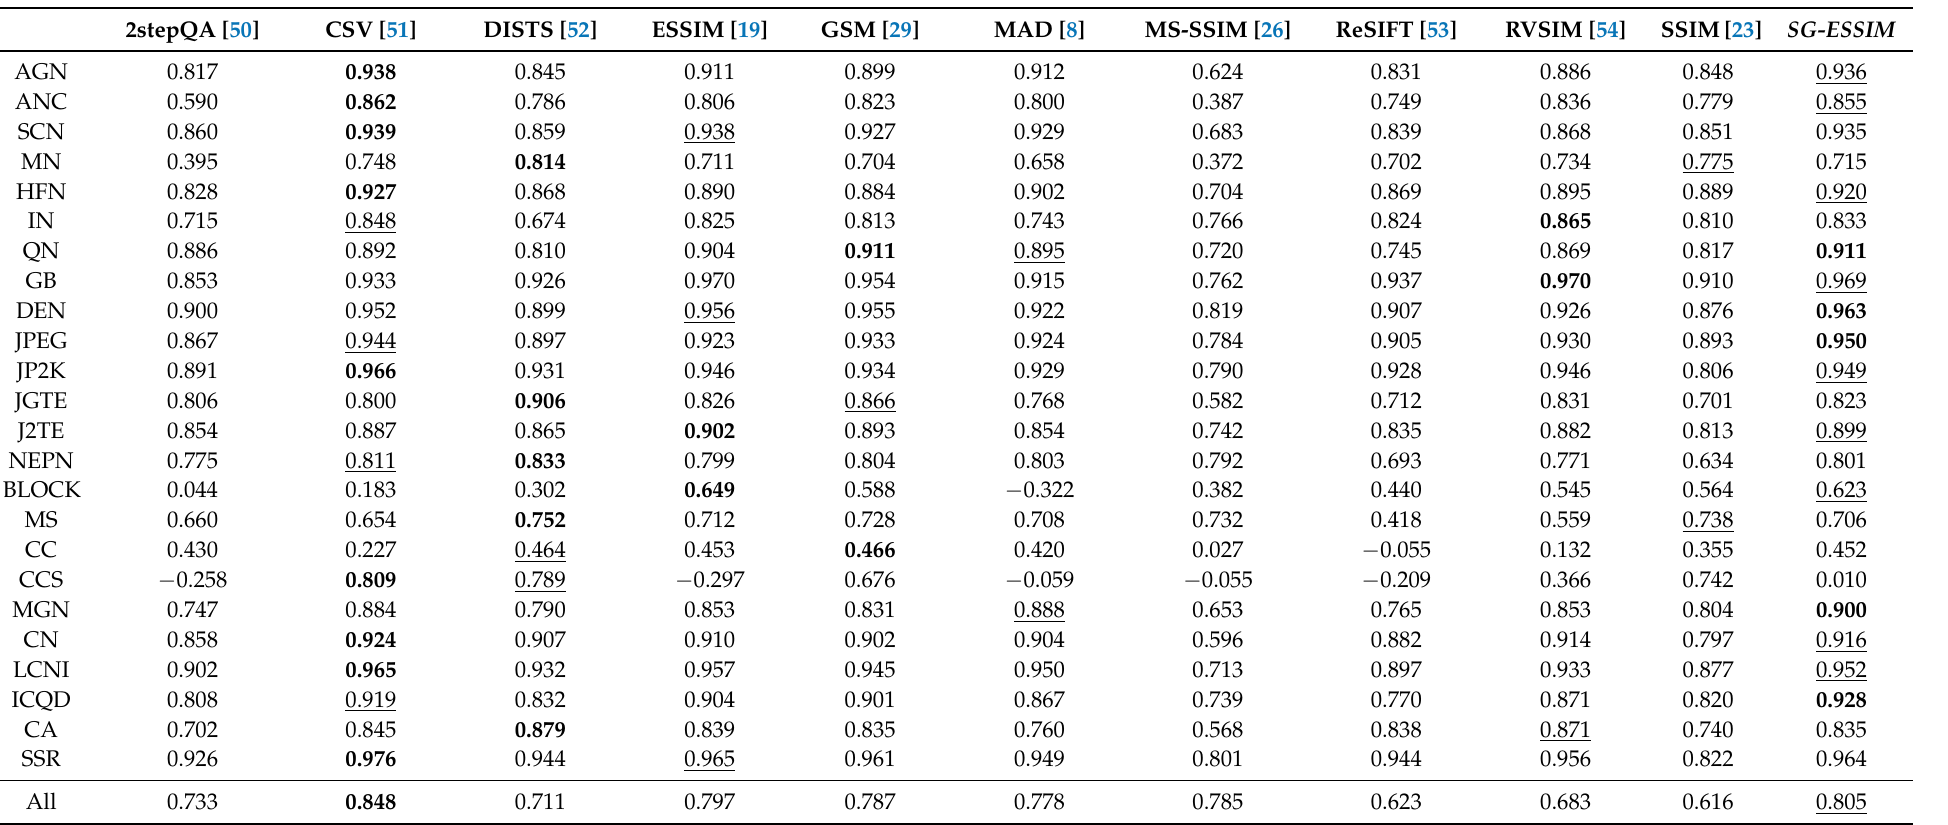
Table 6. Comparison of TID2013’s [7] distortion types. SROCC values are given. The highest values are typed in bold , while the second highest ones are